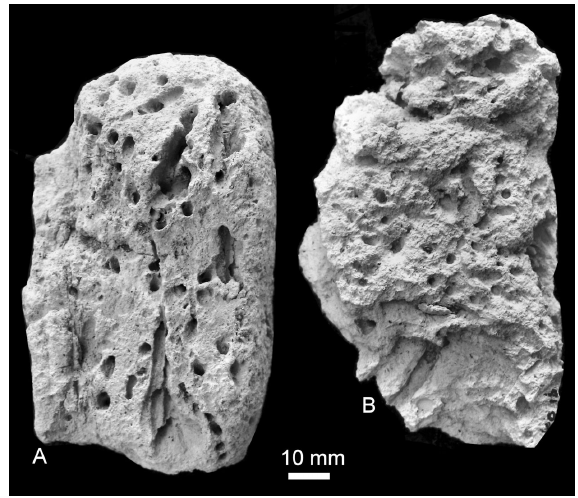
Fig. 6. Boulders of baksteenkalk type 3: A, RGM 1317642, Wilsum; B, RGM 1317643, Kloosterhaar.